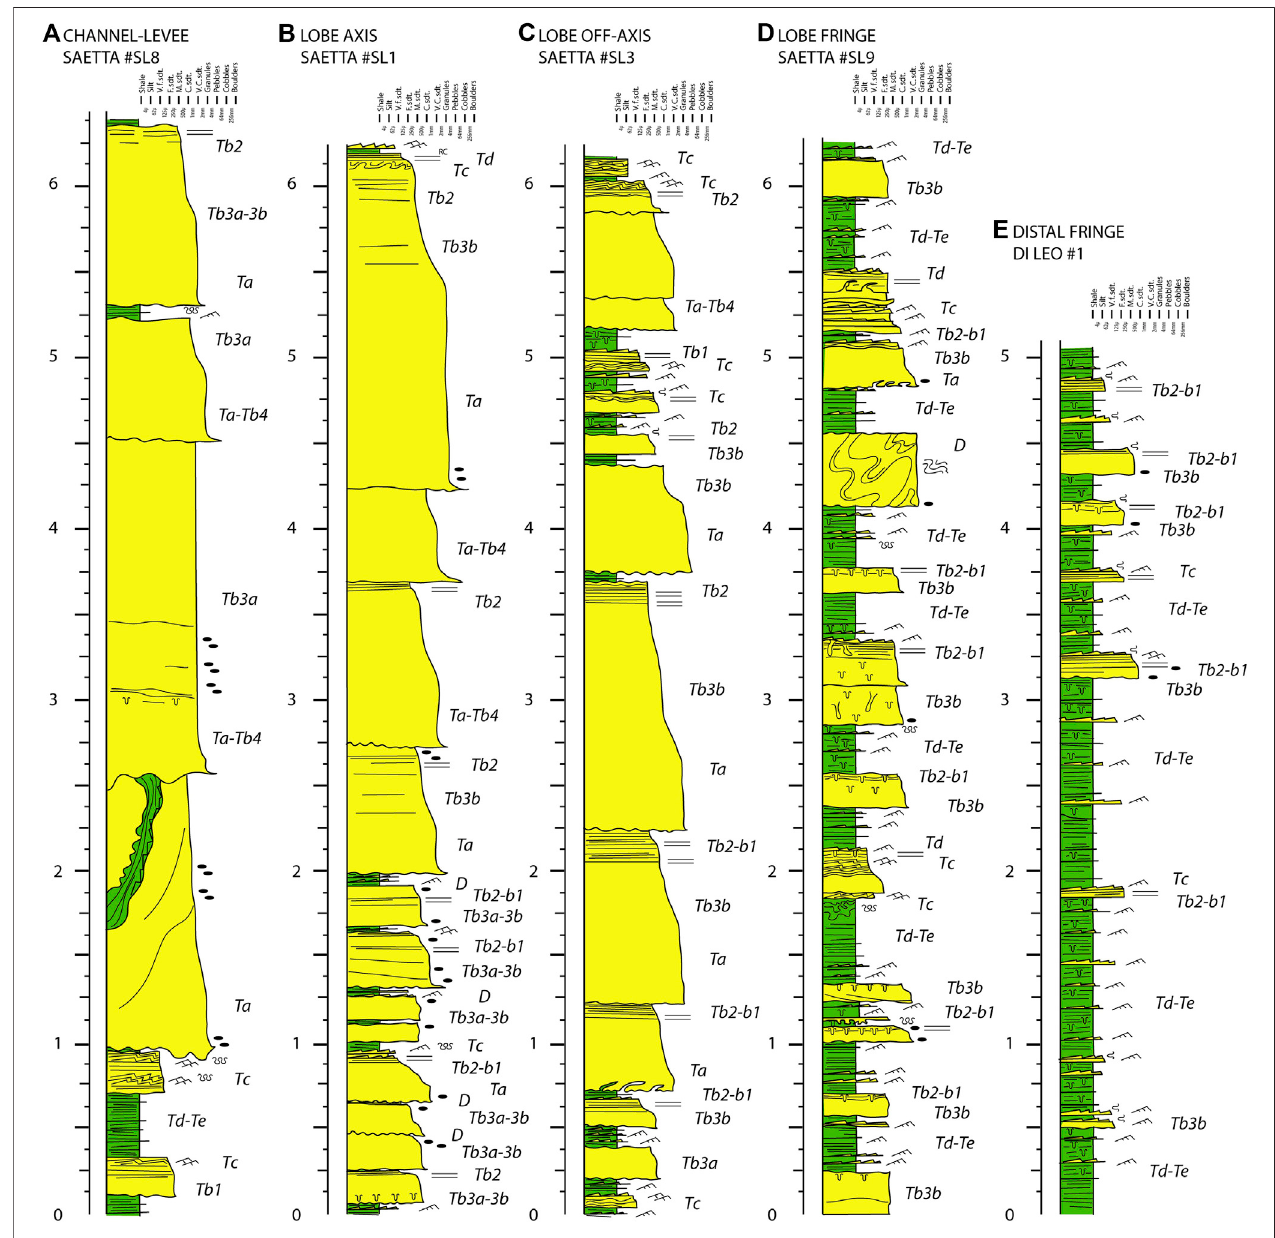
FIGURE 7 | Facies associations and architectural element. (A) Channel and Levee (C-Le) from sedimentological section Saetta #SL8. (B) Lobe axis (LA) from sedimentological section Saetta #SL1. (C) Lobe off-axis (LOA) from sedimentological section Saetta #SL3. (D) Lobe fringe (LF) from sedimentological section Saetta #SL9. (E) Distal lobe fringe (DF) from sedimentological section Di Leo #1.